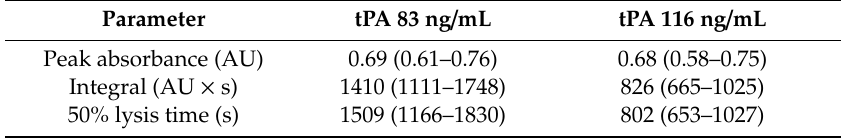
Table 3. Clot-lysis parameters with tissue plasminogen activator (tPA) 83 ng / mL vs. 116 ng / mL.